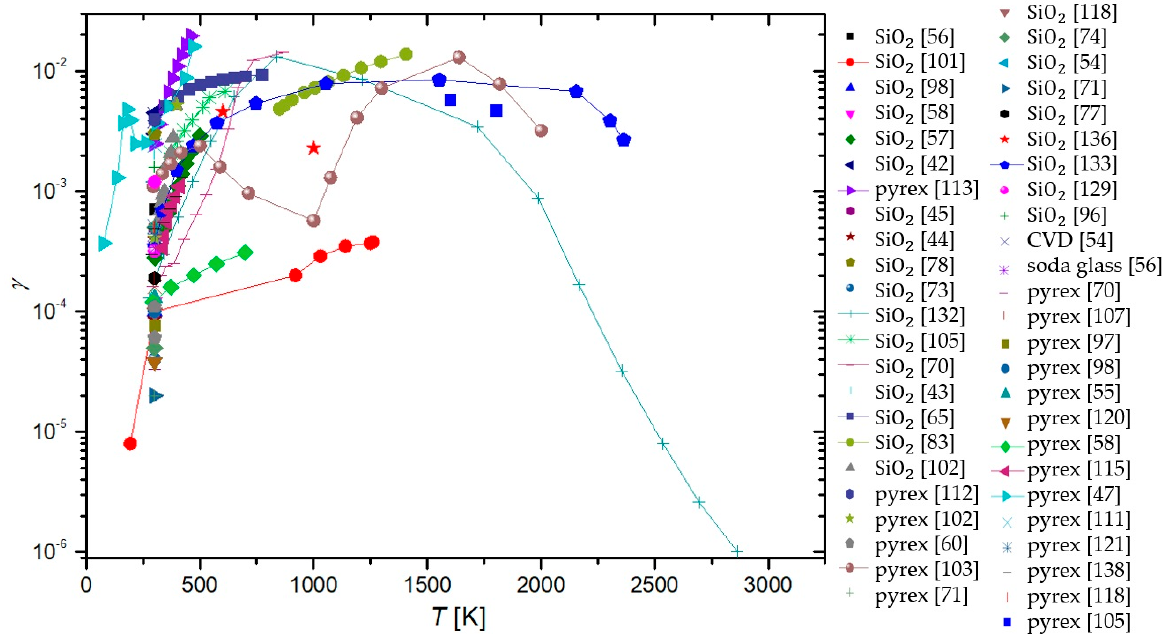
Figure 21. Recombination coefficient ( γ ) of neutral oxygen atoms versus surface temperature ( T s ) for glass surfaces.